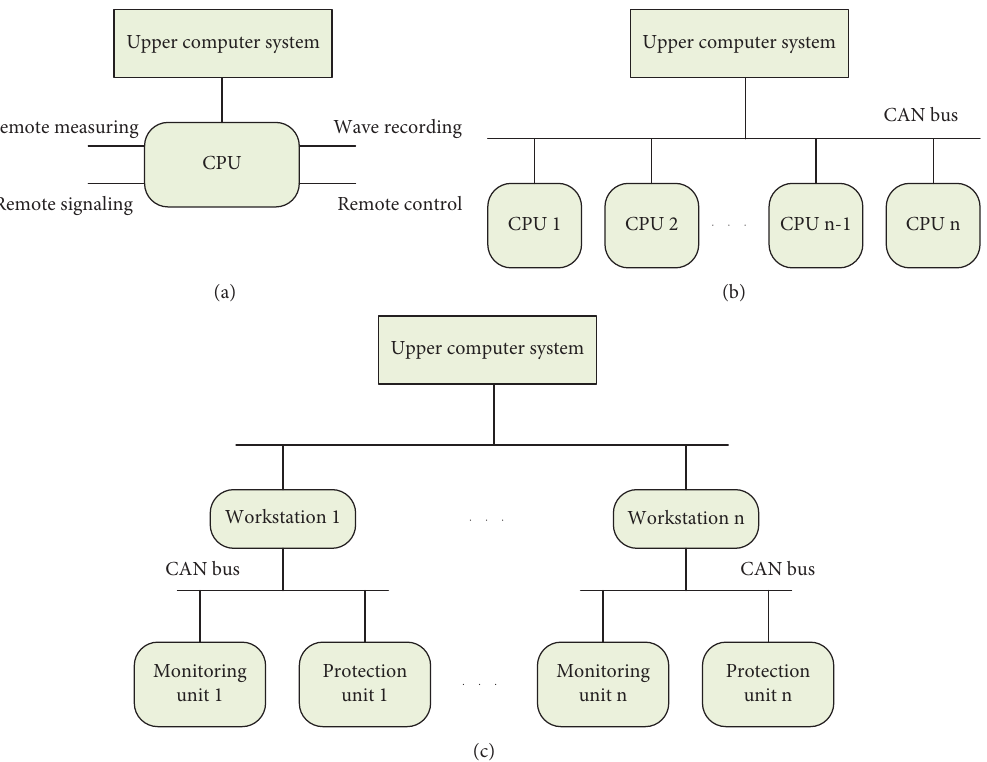
Figure 1: Design mode of the electrical automation control system. (a) Centralized monitoring mode. (b) Remote monitoring mode. (c) Field-bus monitoring